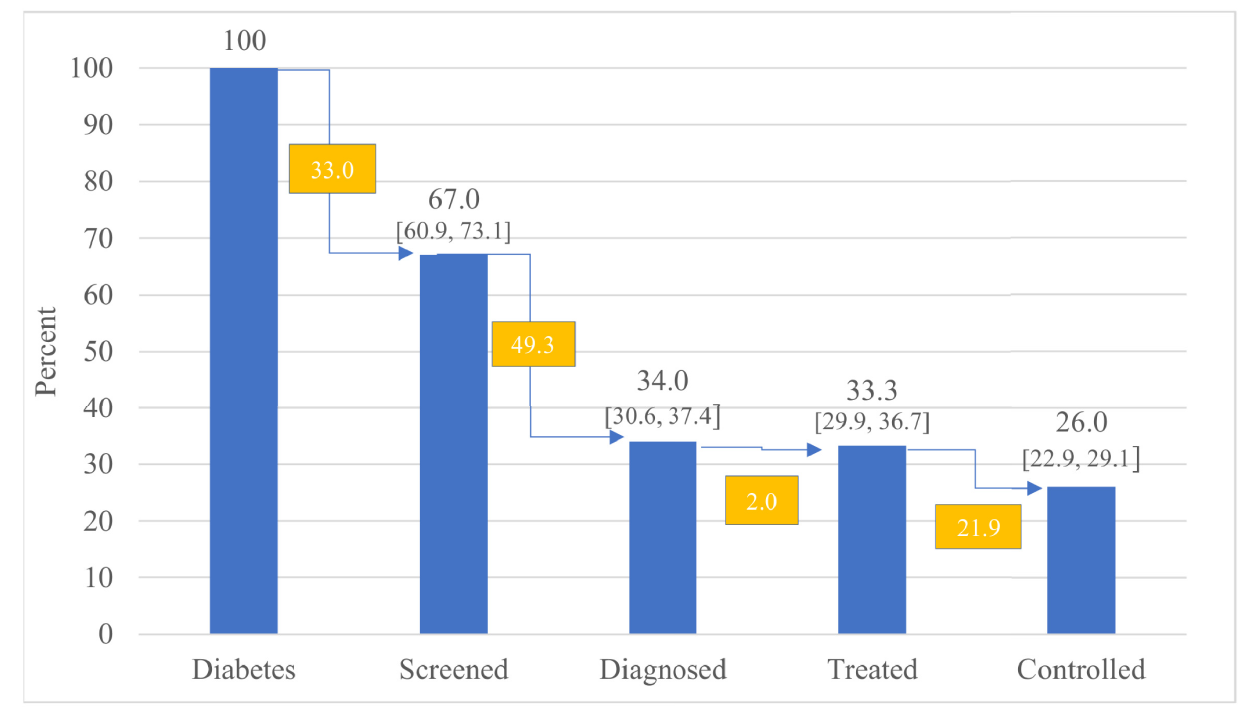
Fig 2. Diabetes care cascade, Thailand 2014. Point estimates are shown, with 95% confidence intervals in brackets. Among all people with diabetes, 67.0% were ever screened for diabetes (33.0% relative loss), 34.0% were ever diagnosed (49.3% loss), 33.3% were ever treated (2.0% loss), and 26.0% were controlled with fasting plasma glucose < 183 mg/dL (21.9% relative loss). Unmet need was 74.0% across the care cascade.